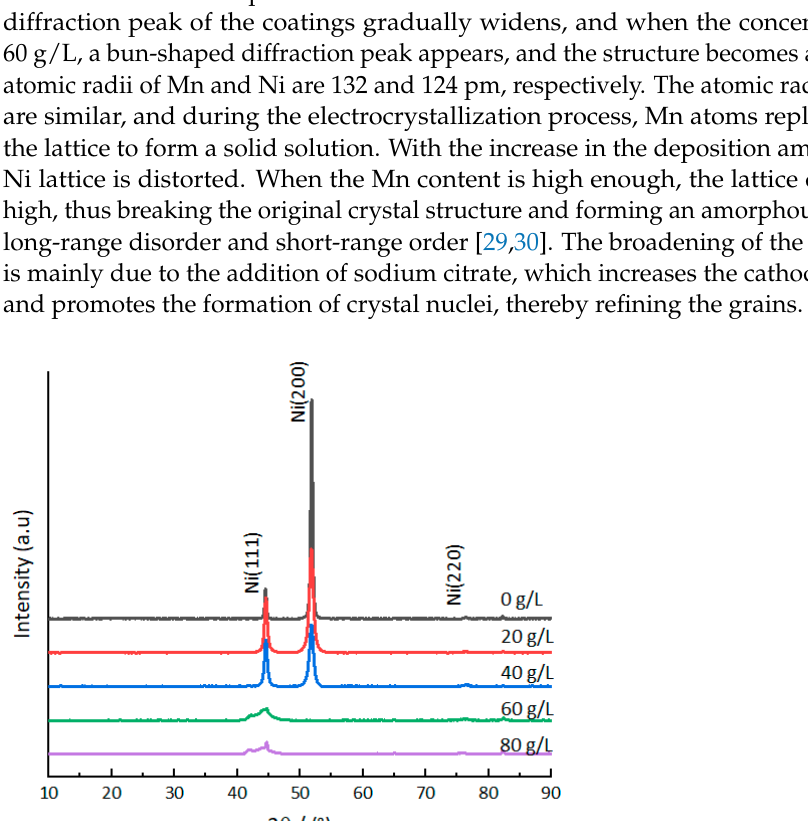
Table 2. Effect of sodium citrate concentration on the composition of coatings.